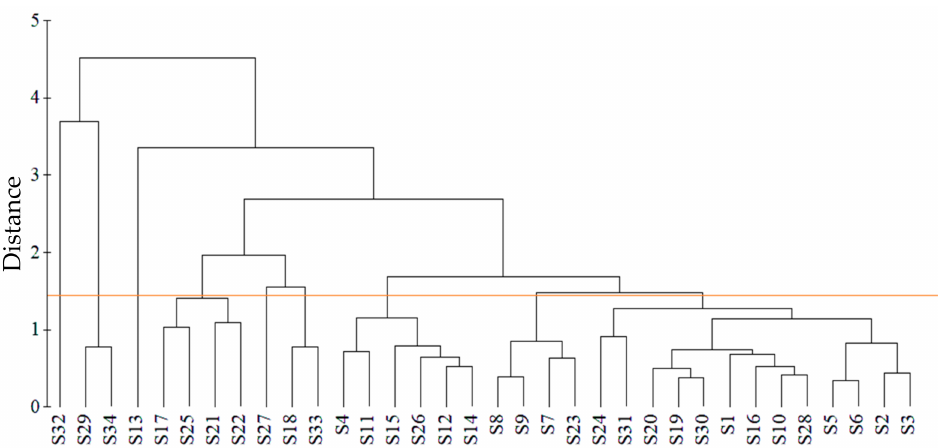
Figure 3. Clustering surface water quality in Tien Giang